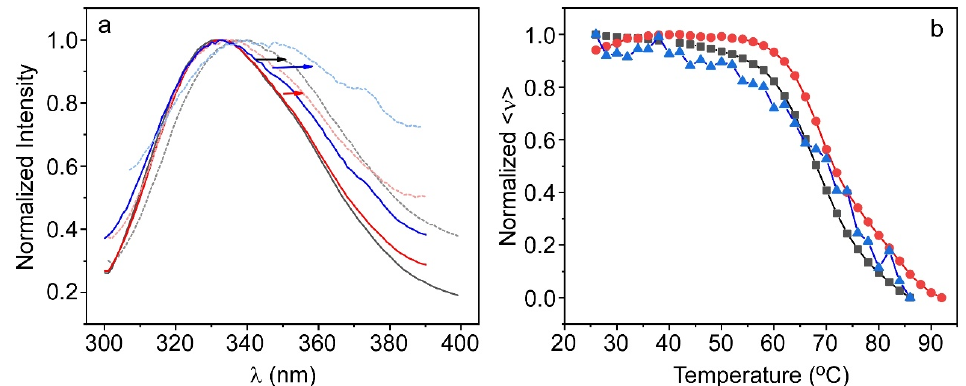
Figure 4. ( a ) Normalized fluorescence emission spectra ( λ x = 290 nm) of freshly prepared ALP@AETA hydrogel (black), rehydrated ALP@AETA xerogel (red) and rehydrated ALP@AETA aerogel (blue) at room temperature (solid lines) and at 86 °C (dashed lines). ( b ) Evolution of the mean fluorescence energy < ν > of hydrated (black squares), post-drying (red circles) and post-lyophilized (blue triangles) ALP@AETA hydrogel.